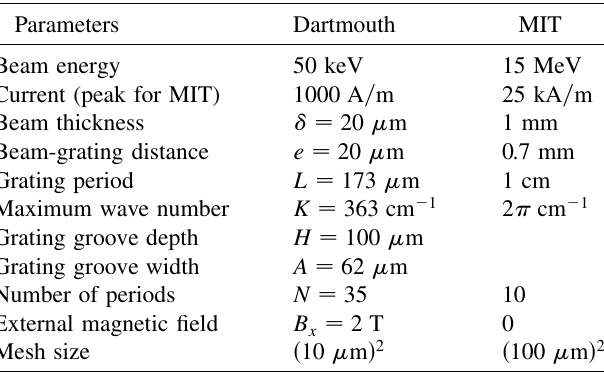
FIG. 1. Simulation geometry. Details of the gratings are shown in the inset. TABLE I. Parameters of the